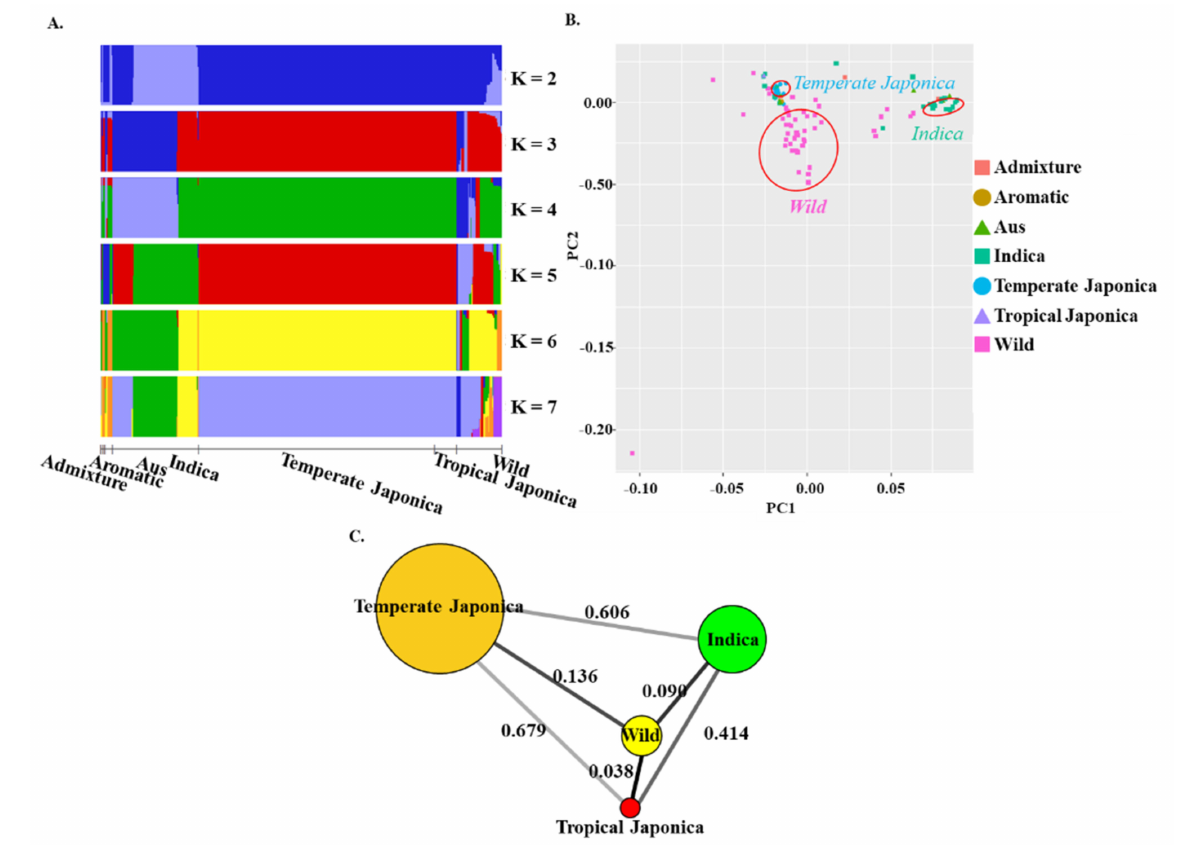
Figure 1. Population structure and diversity in BADH1 ( Os04g0464200 ). ( A ) The population structure of all subgroups based on the BADH1 region using fastStructure to estimate individual ancestry and admixture proportions assuming K populations. With increasing K (number of populations) values from 1 to 10 with 10 iterations each, we analyzed the population structure for each K value (from K = 2 to 7). ( B ) Principal component analysis (PCA) analysis of seven classified ecotypes. Indica and Japonica clustered into clearly defined groups, and other subgroups were located around the two groups. PCA was performed using TASSEL and plotted with ggplot2. ( C ) F ST values between the four classified ecotypes, indicating circle size by the number of accessions. The dark line between each pair represents their genetic